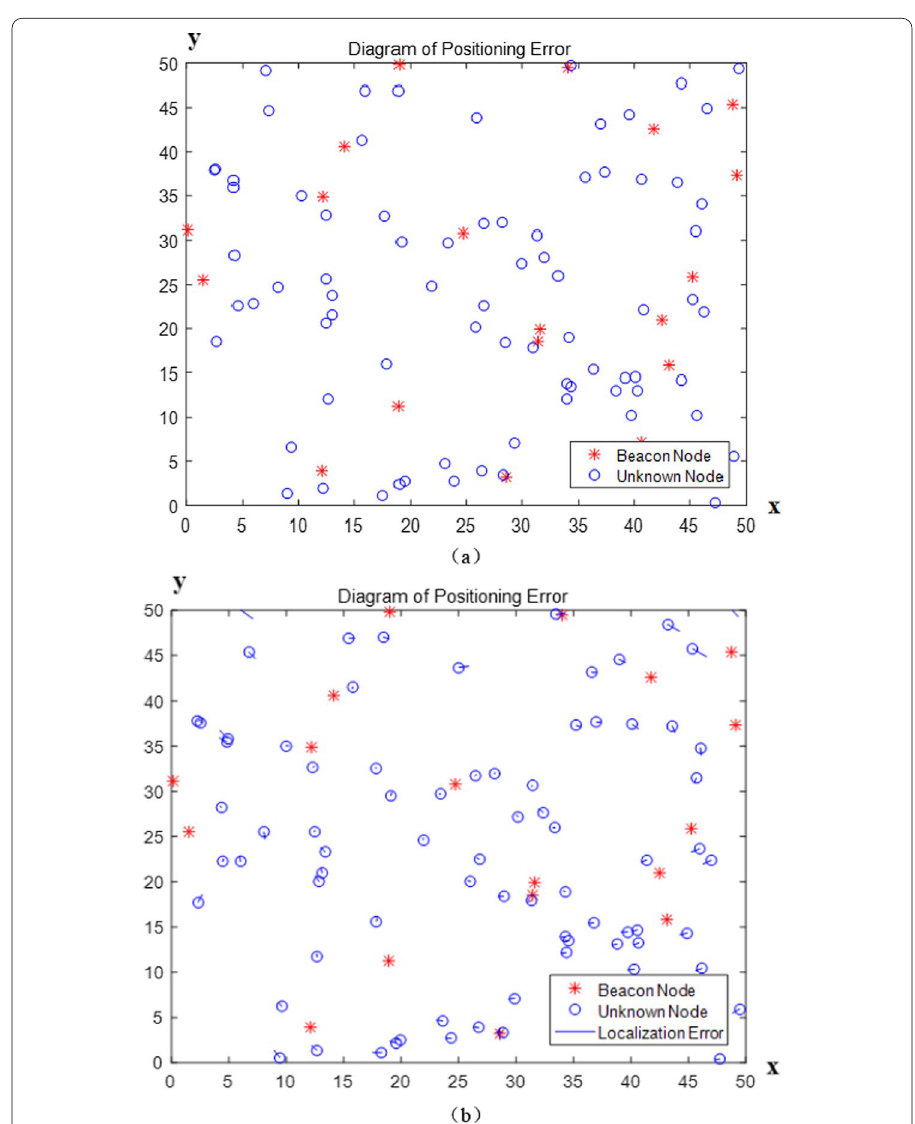
Fig. 4 No error in the beacon noded ( a ) and 2 m error in the beacon nodes ( b ). These figures describe the situation when there are errors and no errors in the beacon